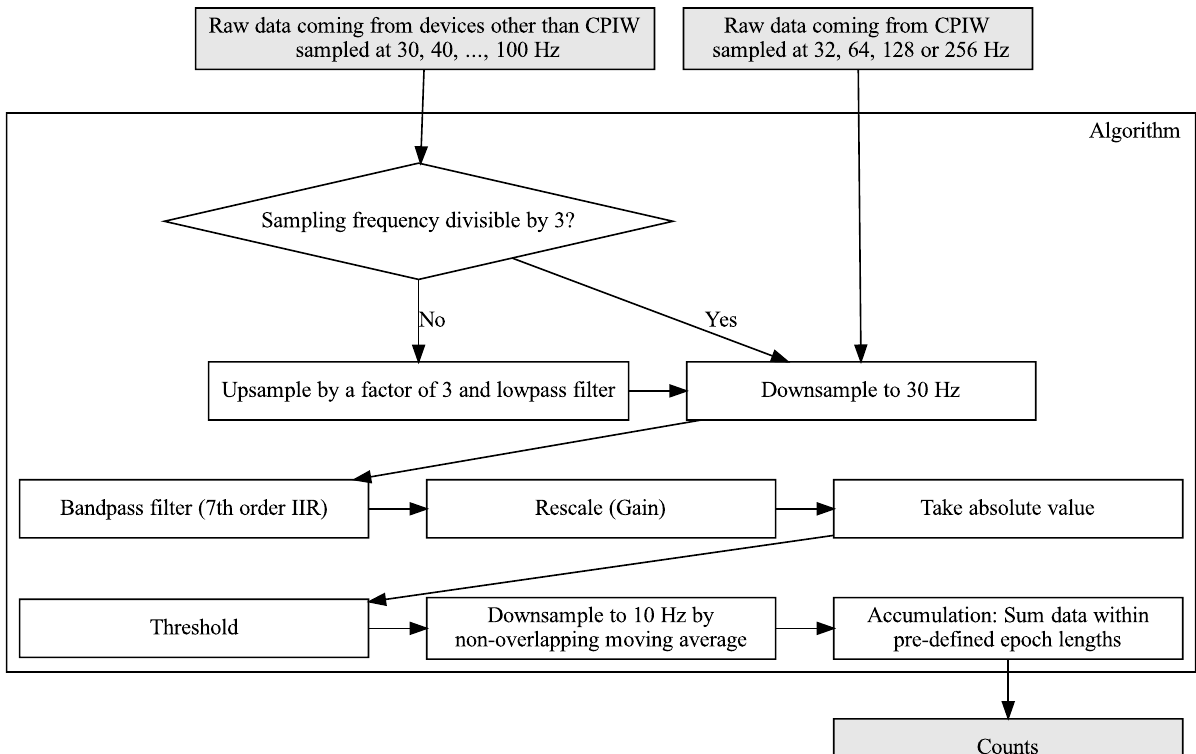
Figure 2. Flowchart showing the process of converting raw data into